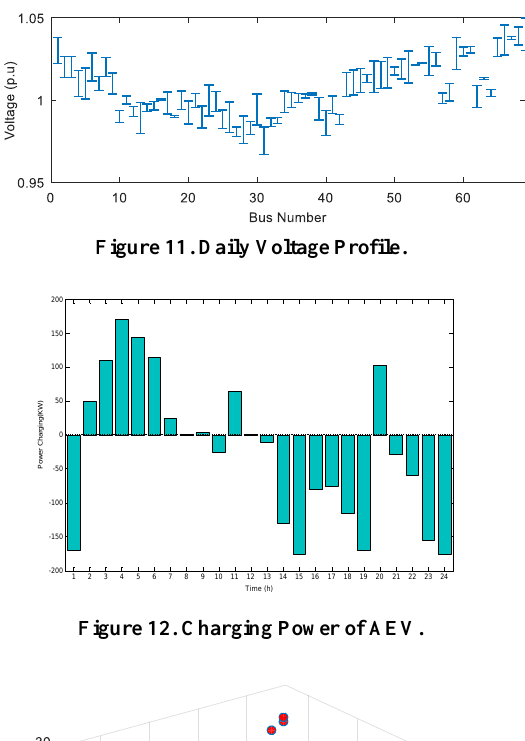
Figure 10. Energy consumption (+) and generation (-) of MG1. Table 2. The number of connection of microgrids. Microgri Connection Generation d